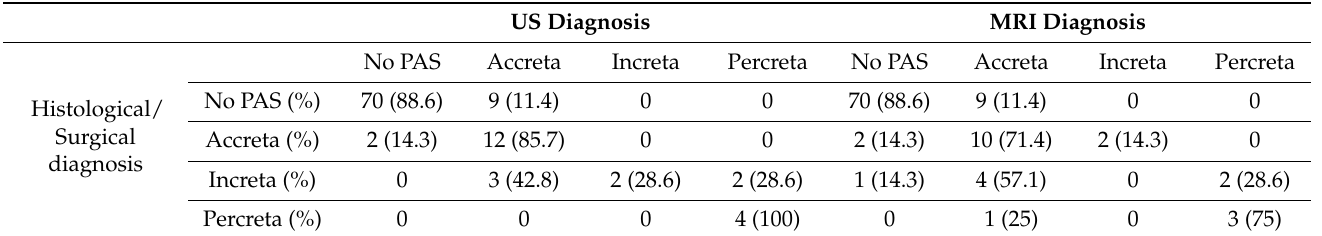
Table 5. Diagnostic ability of US and MRI in correctly identifying the degree of